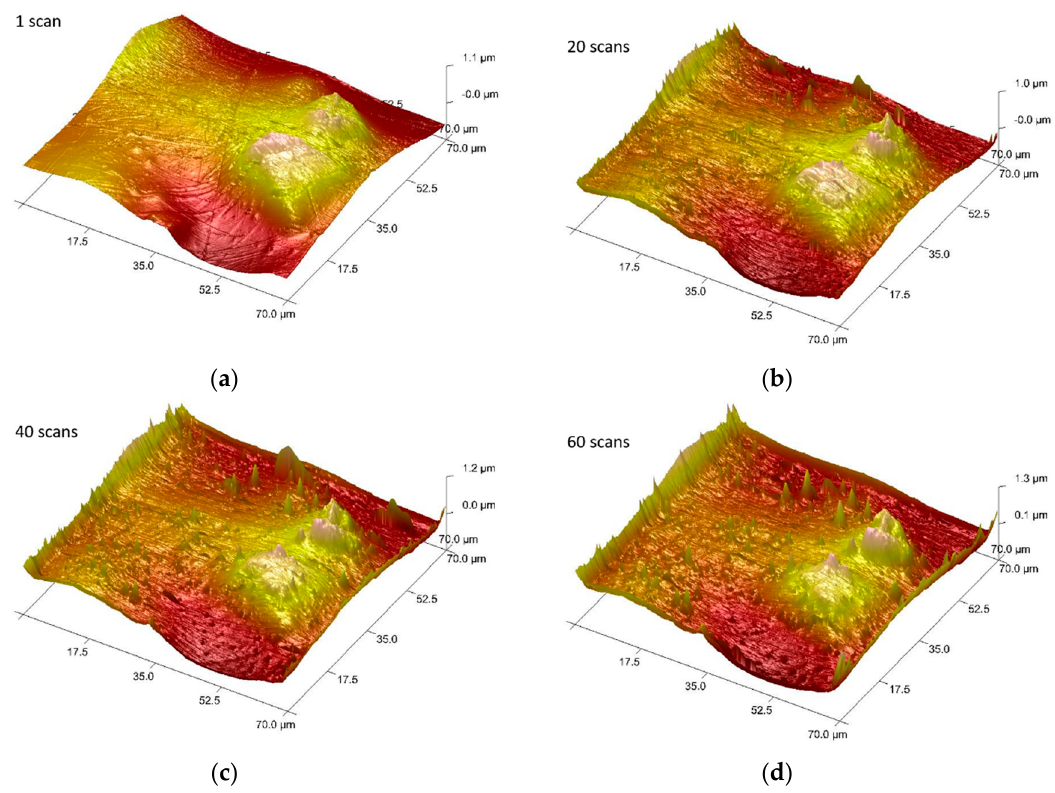
Figure 10. Surface topography evolution of sample g ‐ 0.5 after scratching the surface with several 70 μ m by 70 μ m scan areas at a set ‐ point voltage of 3 V. ( a ) 1 scan; ( b ) 20 scans; ( c ) 40 scans; ( d ) 60 scans.